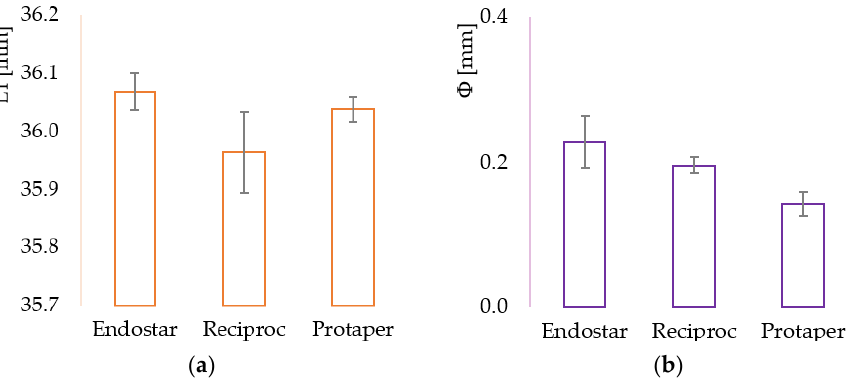
Figure 2. Dimensions of the considered NiTi rotary instruments: ( a ) full length L 1 (mm) and ( b ) tip diameter Φ (mm). Notations: Endostar, Reciproc, and Protaper stand for the three considered groups.